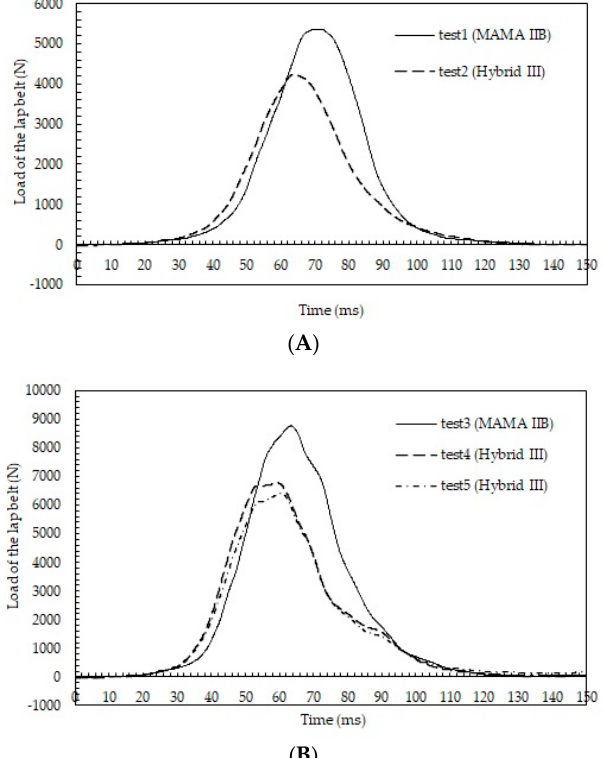
Figure 4. ( A ) Time courses of the loads of the lap belt in tests 1 and 2; ( B ) time courses of the loads of the lap belt in tests 3–5.